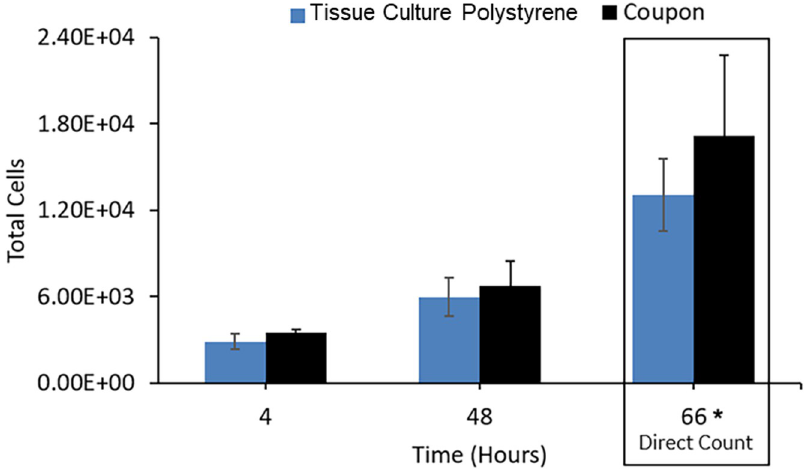
Fig 4. U2OS proliferation on DLP printed HA coupons. Relative luminescence unit (RLUs) were measured from U2OS cells seeded at ~25% (1.75x10 3 cells/cm 2 ) density on polystyrene plates or DLP printed HA coupons using RealTime-Glo TM MT Cell Viability Assay. Cell counts were enumerated based on RLU measurements for the 4 and 48 hour time points using a standard curve correlating cell count and RLU (S7 Fig). Direct cell count was done at 66 hours of incubation by image analysis (counted cell nuclei). U2OS cells proliferation rates were similar on coupons and tissue culture polystyrene plates (P > 0.5; using T-test, differences were not statistically significant).